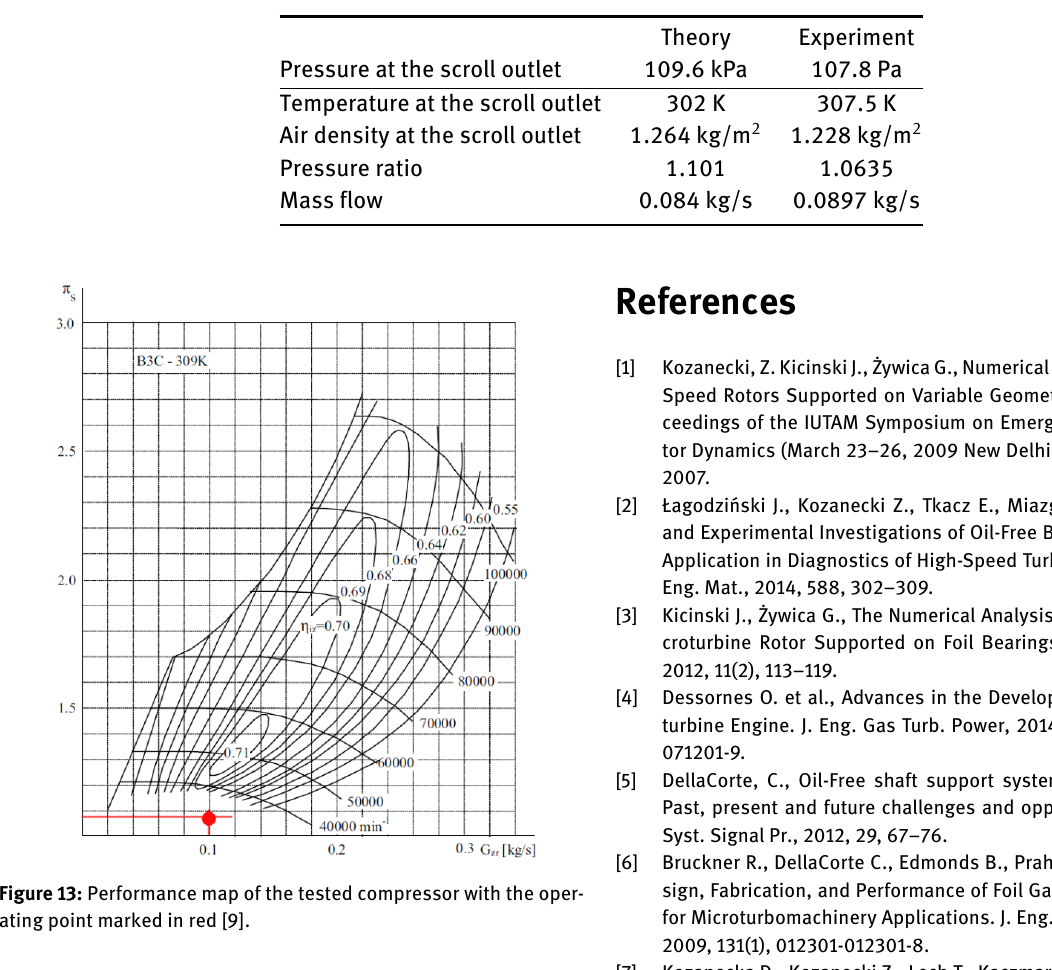
Table 1: Comparison of the theoretical and experimental results at 30 000 rpm.